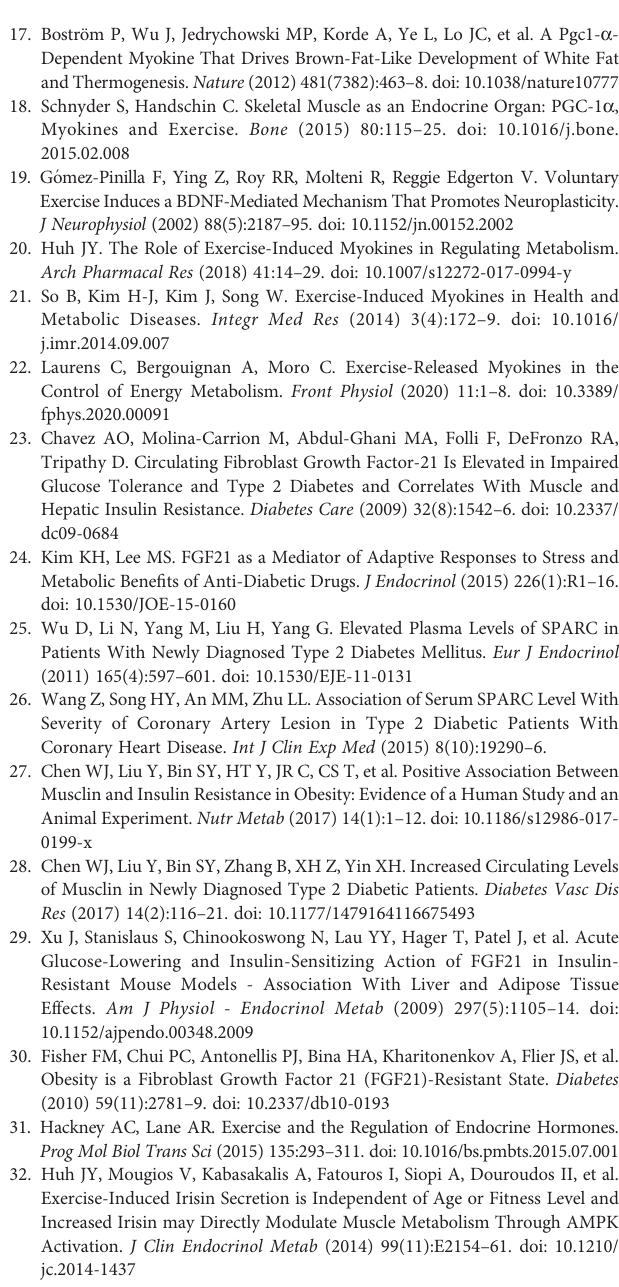
Supplementary Figure 1 | Change in animal ’ s body weight (grams) in low response trainers (LRT) and high response trainers (HRT). Values are means±SD. Analysis via two-way ANOVA with Sidak ’ s post hoc test. Main effects are shown in the text box **P<0.01, ***P<0.001, ****P<0.0001. Non-underlined symbols represent within group differences. Underlined symbols represent between group